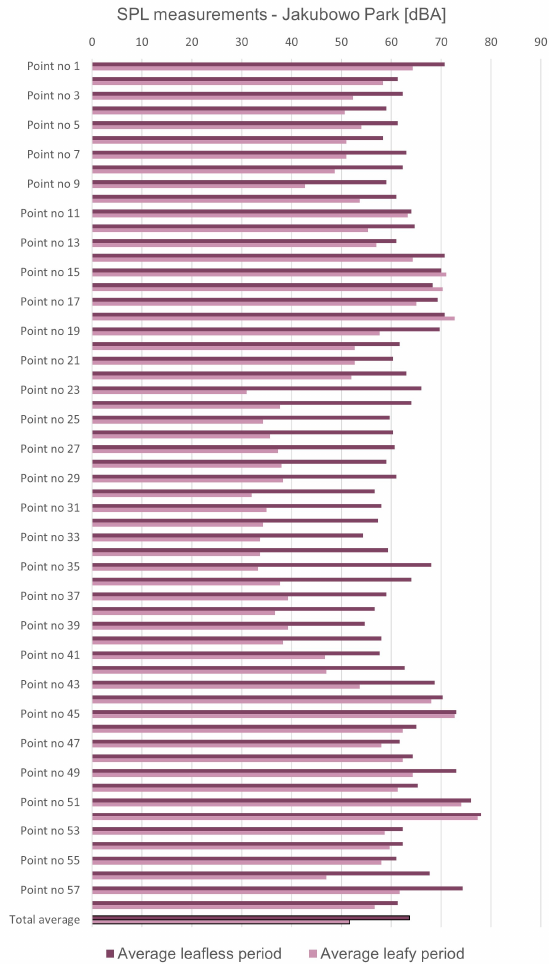
Figure 6. SPL measurements in dBA—Jakubowo Park.